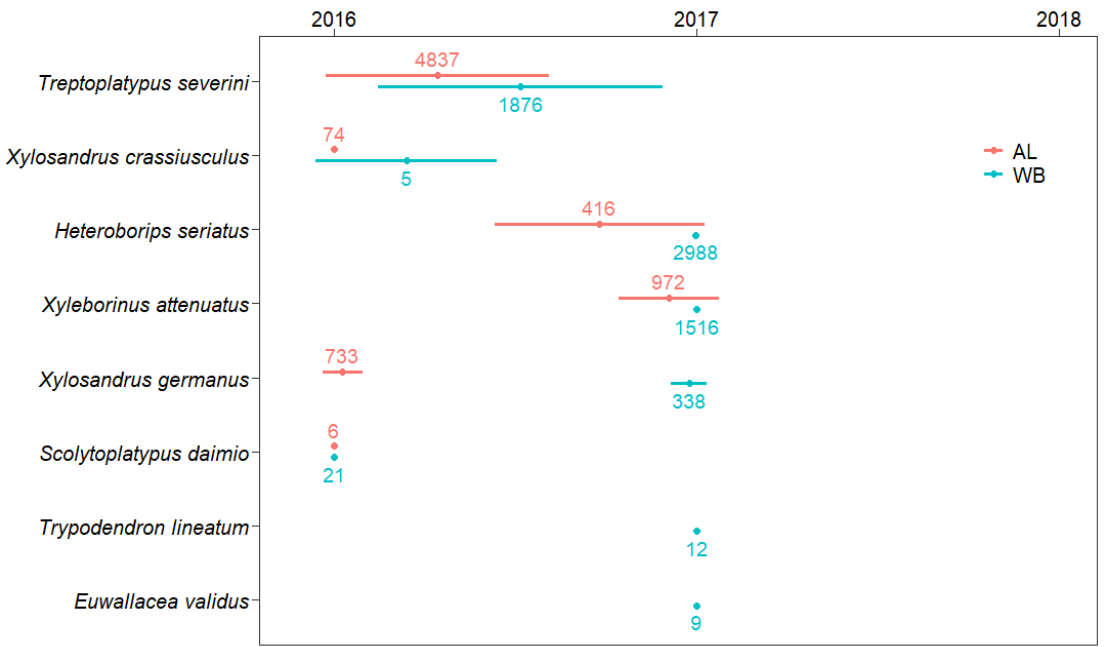
Figure 4. Niche center (dots) and breadth (bars) of the colonization timing of each insect species in the logs of alder (AL) and white birch (WB). The numbers indicate the total abundance (number of galleries with beetles) of each insect species. Here, the niche center ( N c ) was calculated as the weighted mean of relative resource preference using the Equation: N c = ∑ f i x i [33], where f i is the relative resource preferences of the species in the i th sampling year and x i is the position value of the i th sampling year. The niche breadth ( B d ) was measured as the uniformity of the species distribution among sampling years using the Shannon–Wiener formula: B d = − ∑ f i lnf i [34]. Niche breadth is minimized to zero when all individuals of a species are found in only one sampling year. Scolytoplatypus mikado was excluded because of the singleton. The results of the generalized linear mixed model (GLMM) indicated that the tree species and insect species both had marginally signif- icant effects on the niche center ( p = 0.063 and p = 0.061, respectively), but did not affect the niche breadth. Table 2. Effects of tree species and insect species on the niche center and breath of ambrosia beetles found in alder and white birch logs, analyzed using a generalized linear mixed model. For the tree species effect, alder was used in the base model with the insect species as the random effect. For the insect species effect, Xyleborinus attenuatus was used in the base model with the tree species as the random effect.